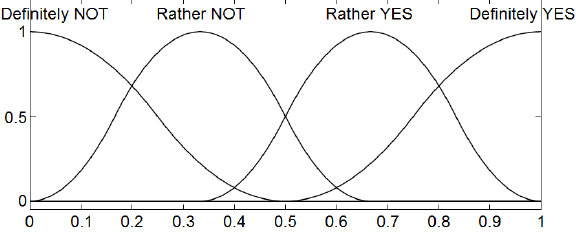
Figure 10: Membership function for the output variable y – IRF(Uph) , complex functions (linear quadratic)